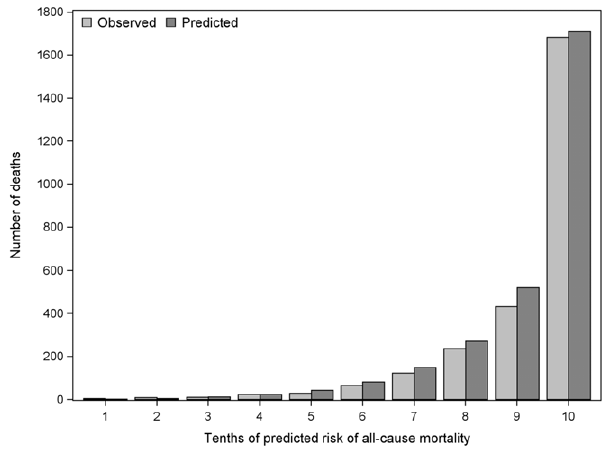
Figure 2. Number of predicted and observed mortality events one year after initial